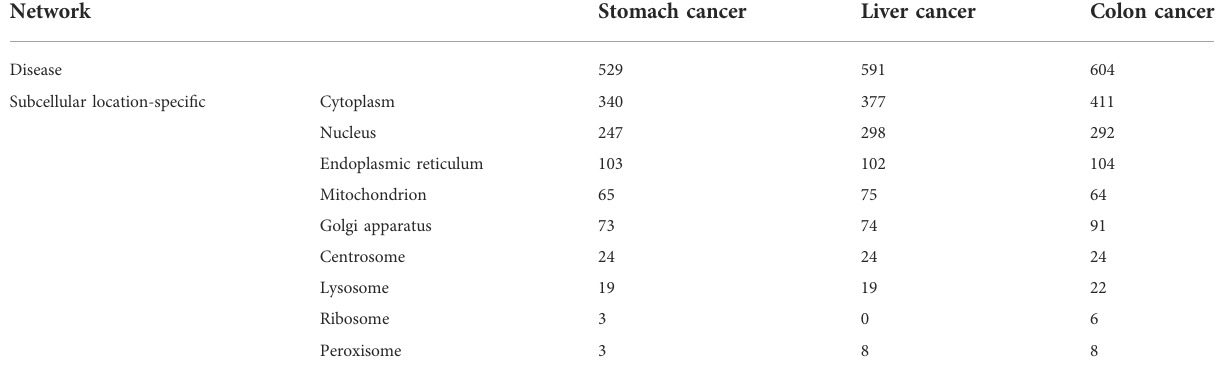
TABLE 3 Number of candidate leader genes for stomach, liver, and colon cancers.